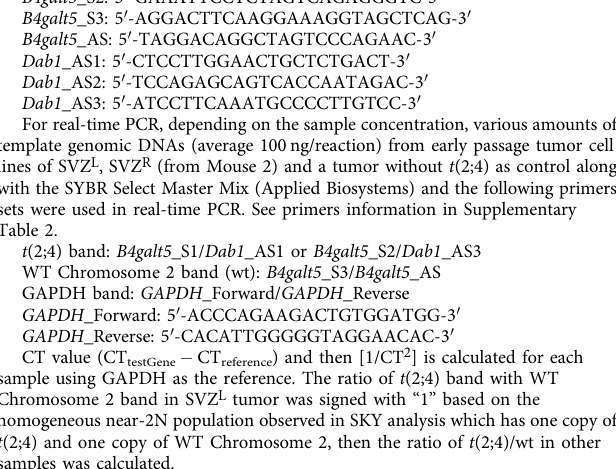
sample using GAPDH as the reference. The ratio of t (2;4) band with WT Chromosome 2 band in SVZ L tumor was signed with “ 1 ” based on the homogeneous near-2N population observed in SKY analysis which has one copy of t (2;4) and one copy of WT Chromosome 2, then the ratio of t (2;4)/wt in other samples was calculated.